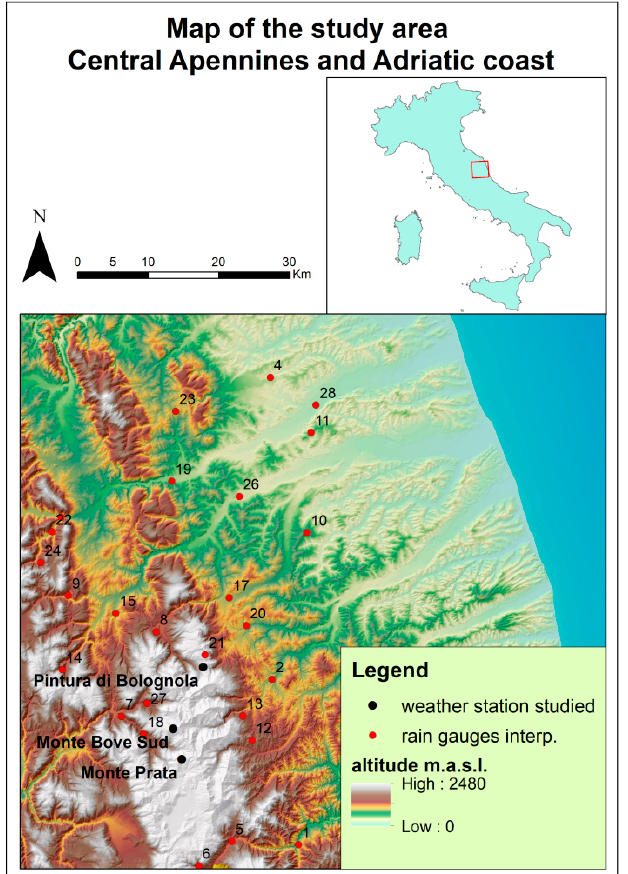
Figure 1. Geographic map of central Italy; blue dot for the mountainous weather stations under investigation, red dot for interpolation rain gauges.